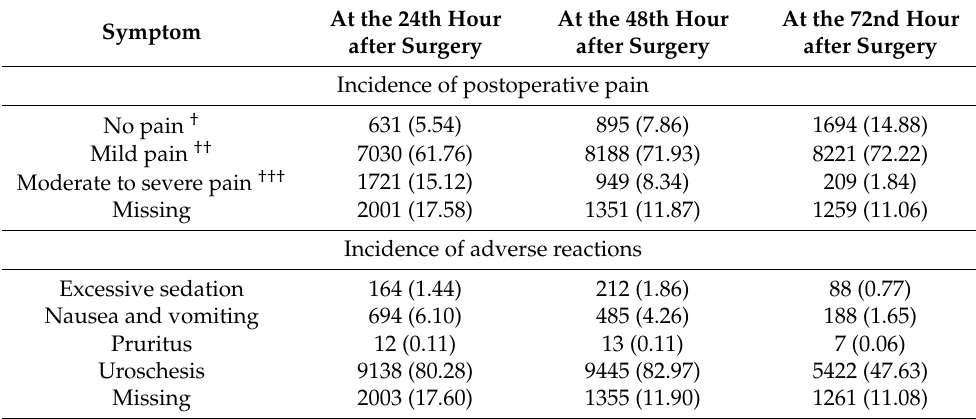
Table 2. Incidence of postoperative pain and adverse reactions in three